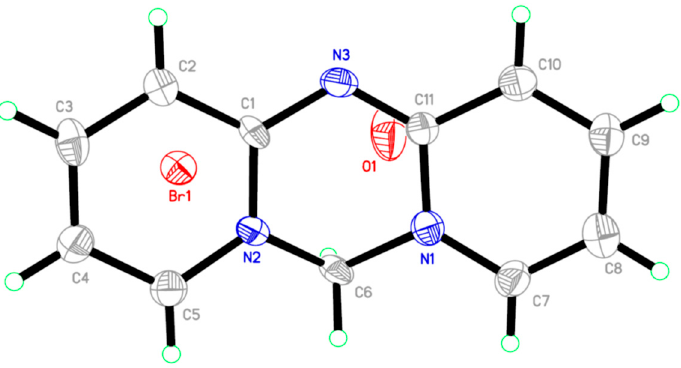
Figure 6. The molecular structure of Azacyanine 1 (the ellipsoids were at a 50% probability level).